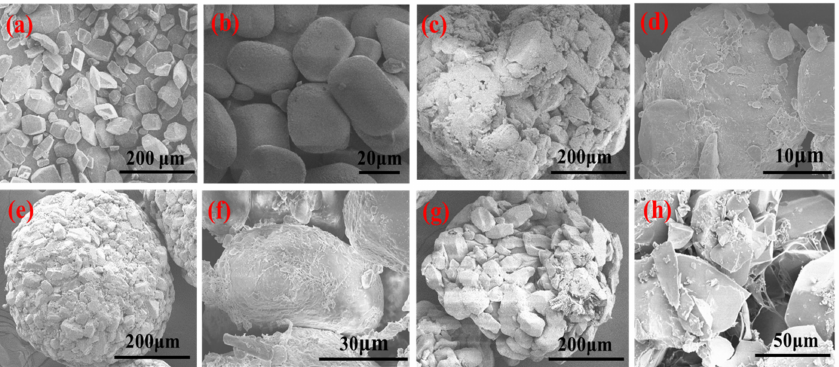
Figure 4. The SEM images of ( a ) raw material ε -CL-20; ( b ) high quality ε -CL-20; ( c ) sample NO.1; ( d ) surface of sample NO.1; ( e ) sample NO.2; ( f ) surface of sample NO.2; ( g ) sample NO.4; ( h ) surface of sample NO.4.